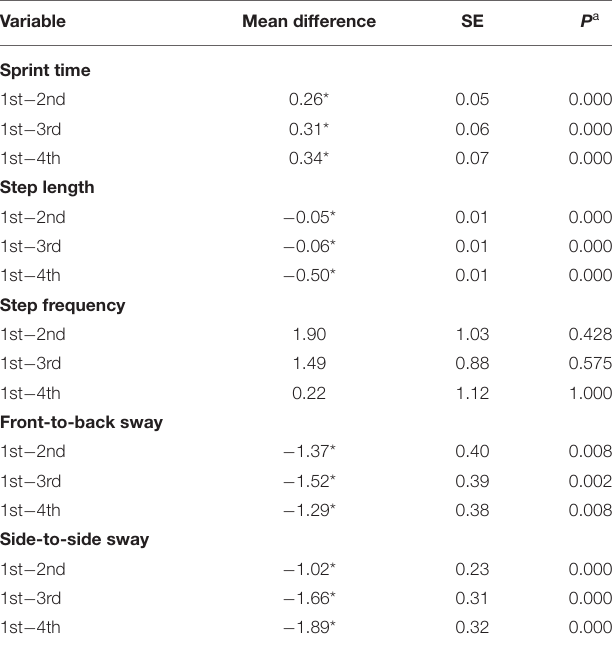
The mean difference column represents the differences between the means of each biomechanical variable at each given sprint trial. SE, standard error; P a , Significance level with Bonferroni adjustment. * p <